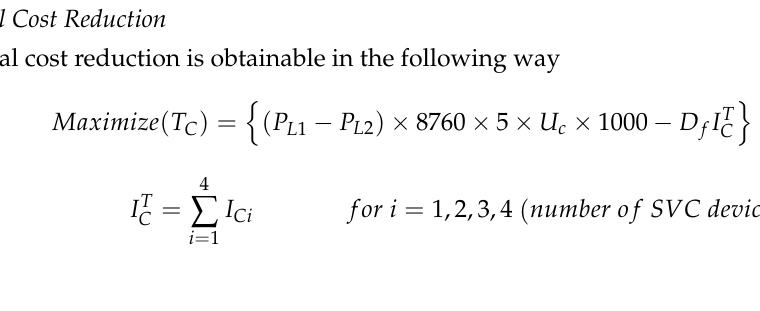
Figure 5. Convergence Curve GA for optimal size of